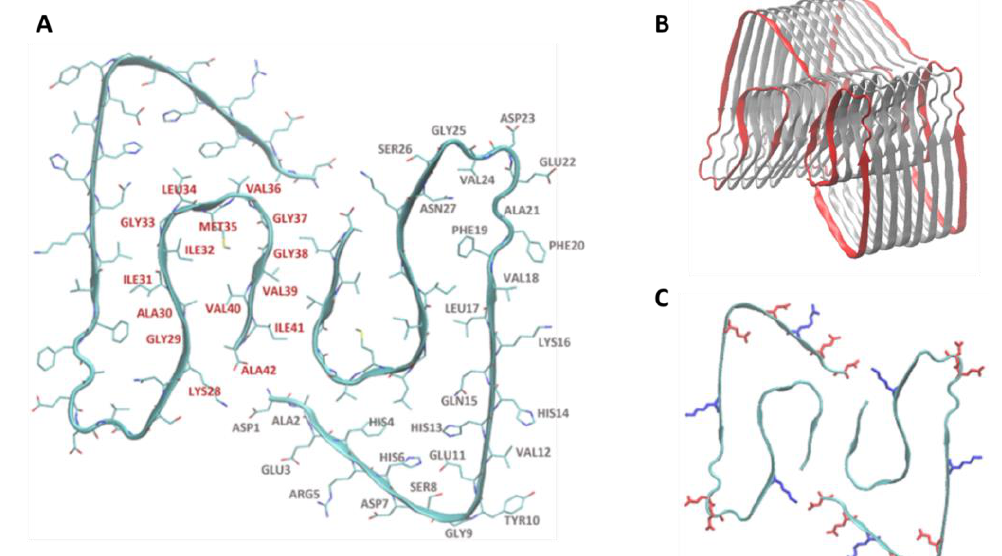
Figure 2. Molecular model of the A β fibril. ( A ) Frontal view of A β (1-42) fibrillary structure: in red are represented residues of group A, and in gray the residues of group B. ( B ) Side contact (gray) and frontal contact (red) areas. ( C ) Representation of two “1–42” amino acid chains that compose the fibril. The positively charged residues are highlighted in blue, while the negatively charged residues are highlighted in red.